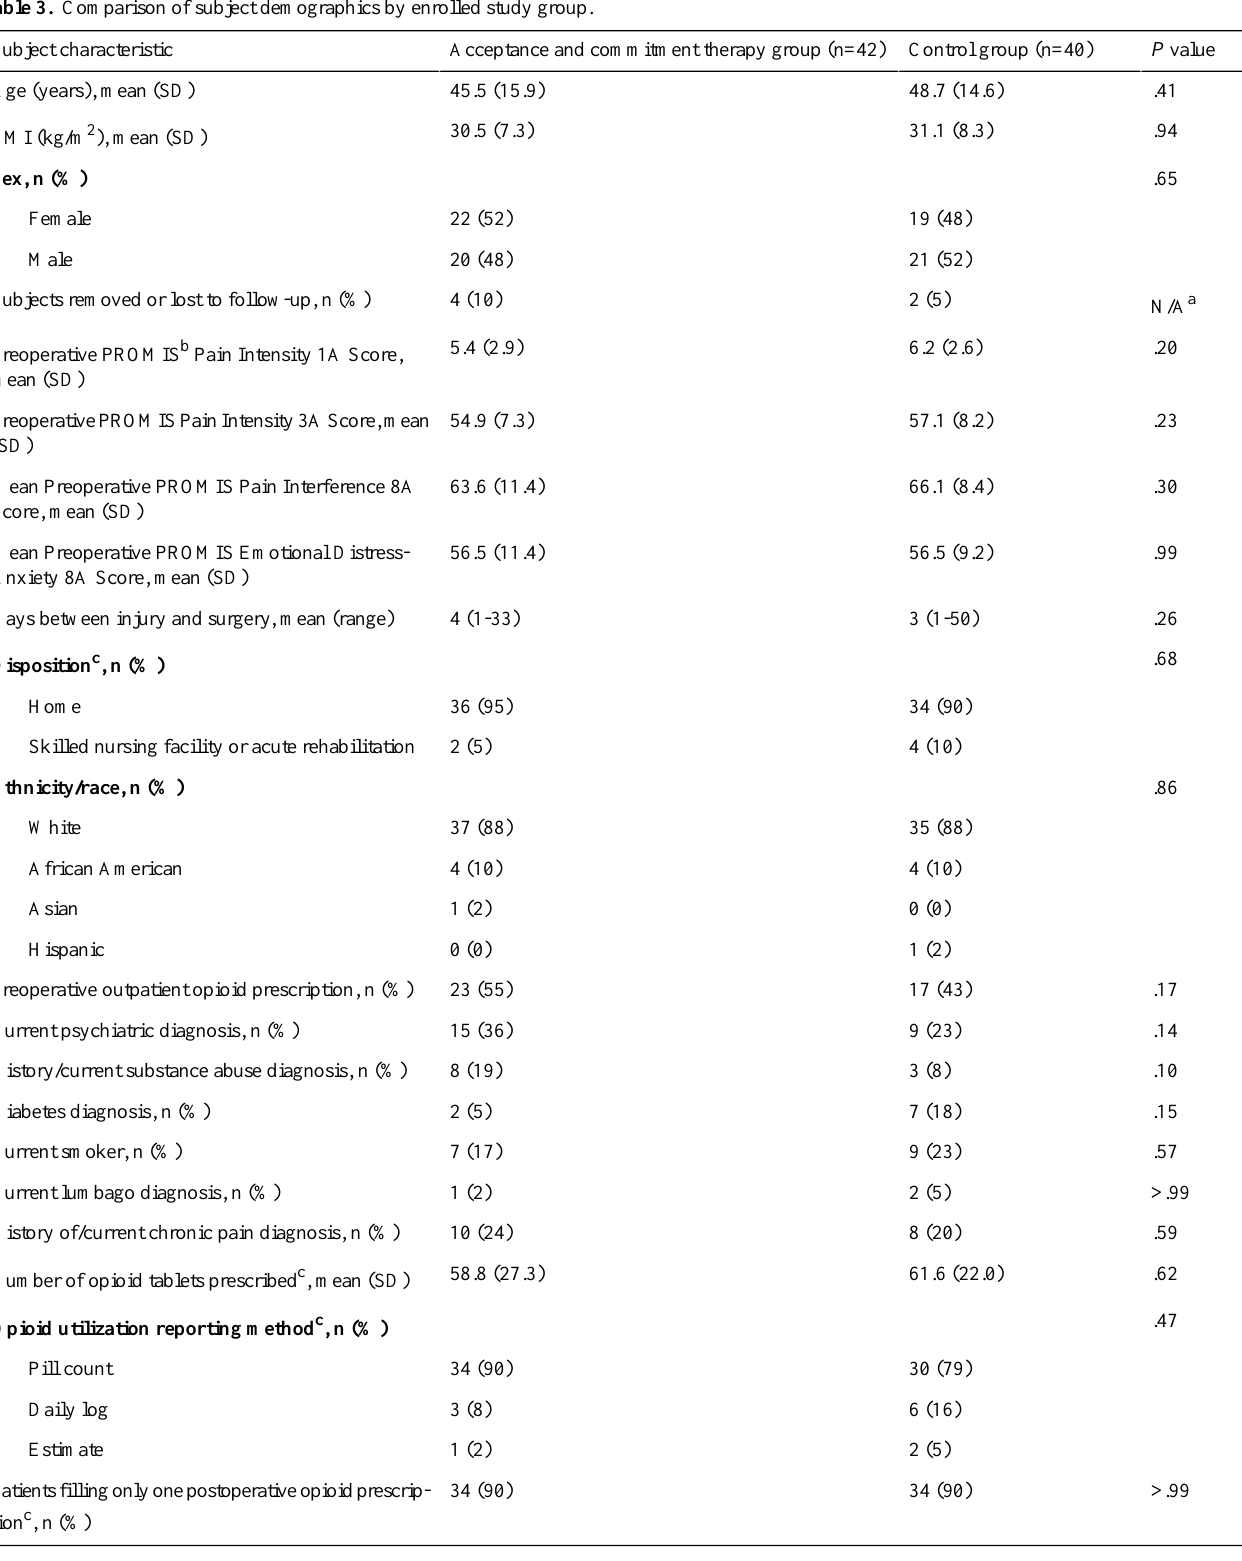
Table 3. Comparison of subject demographics by enrolled study